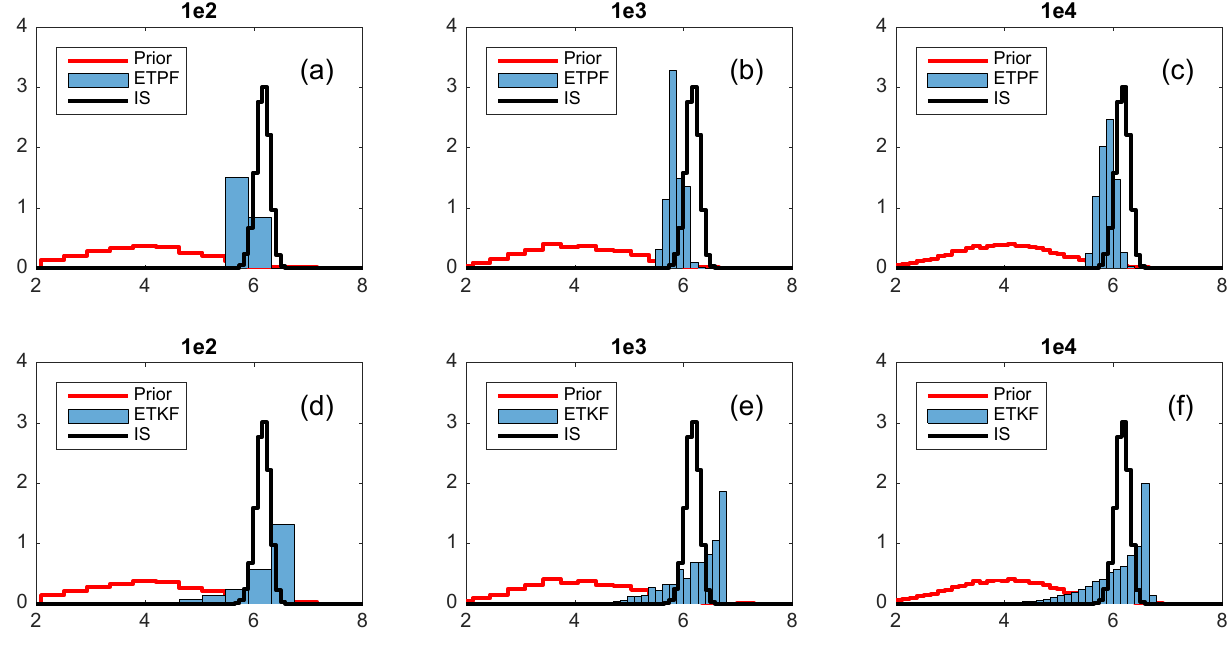
Figure 1. Probability density functions for the one-parameter nonlinear problem. Top: ETPF; bottom: ETKF. (a, d) Ensemble size 10 2 ; (b, e) ensemble size 10 3 ; (c, f) ensemble size 10 4 . Prior is in red. The true pdf obtained by IS with ensemble size 10 5 is in